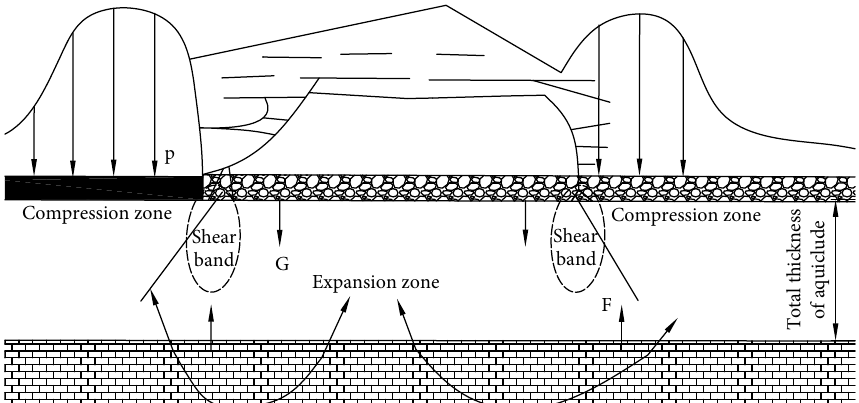
Figure 10: Distribution diagram of fl oor failure stress with in fl uence of the falling roof considered.